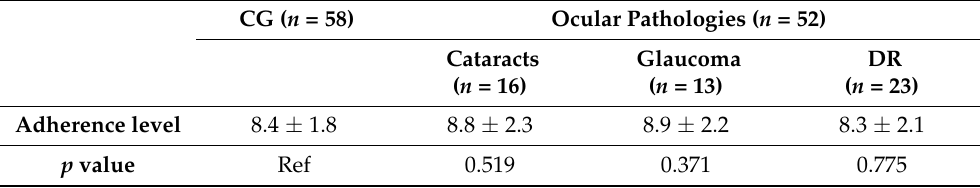
Table 3. Adherence to MedDiet in eye patients and healthy controls